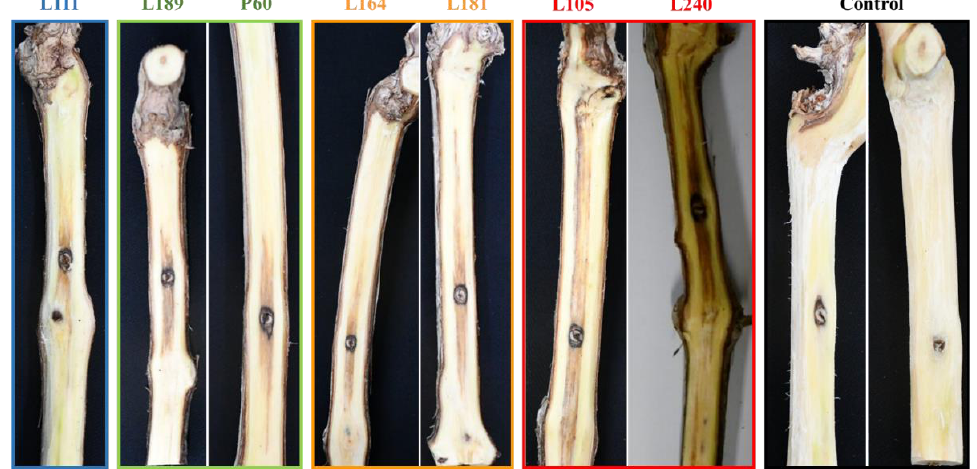
Figure 7. Pathogenicity of Sporocadaceae isolates collected in Cyprus vineyards on 2-year-old vines (cv. Xynisteri). Wood discoloration caused on lignified canes by isolates L111 : Seimatosporium cyprium ; L189 and P60 : Sei. vitis-viniferae ; L164 and L181 : Sporocadus kurdistanicus ; L105 and L240 : Spo. rosigena 12 months after inoculation. The control (non-inoculated) vines exhibit no disease symptoms.